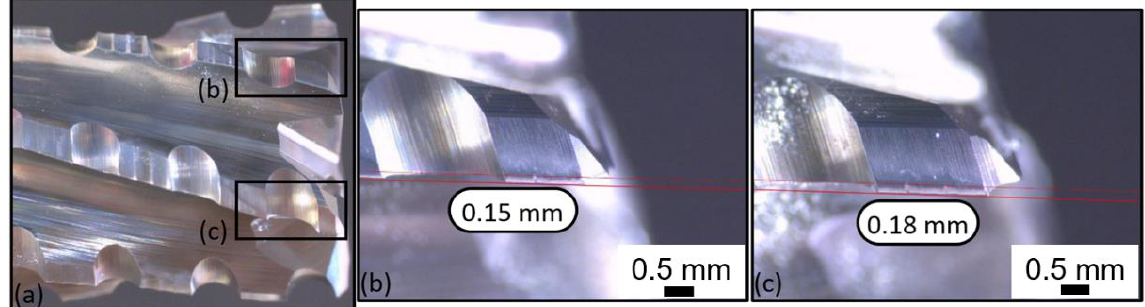
Figure 18. T2: Lateral view at the worn state: ( a ) global view of the end-mill, ( b ) zoom on a clearance face and ( c ) zoom on another clearance face.